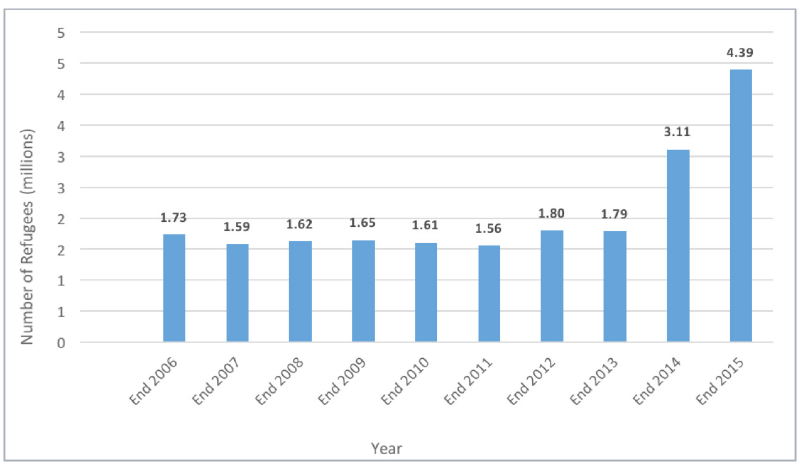
Figure 3. Number of refugees in Europe between 2006 and 2015. (data taken from UNHCR Global Trends